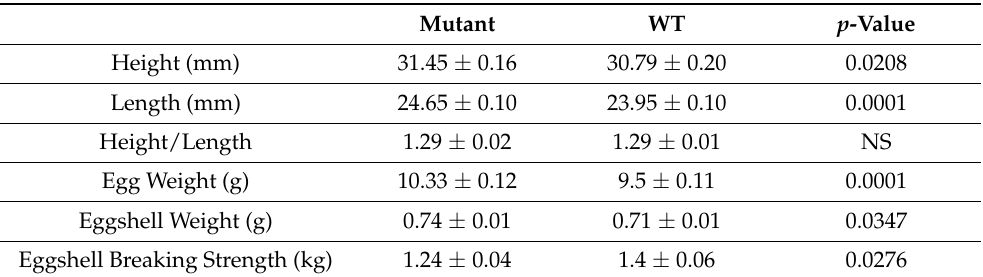
Table 1. Comparisons of eggshell qualities between myostatin (MSTN) mutant eggs and wild-type (WT) eggs.